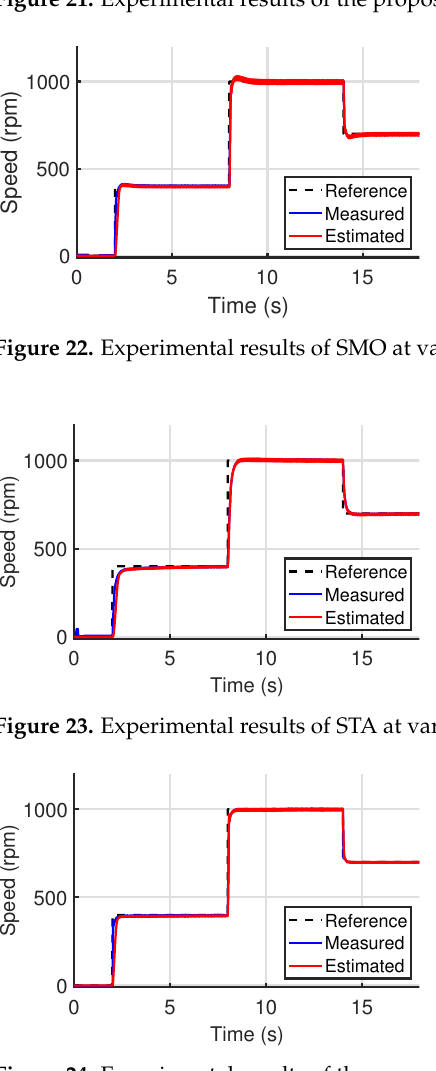
Figure 21. Experimental results of the proposed observer under 60 rpm to 30 rpm.